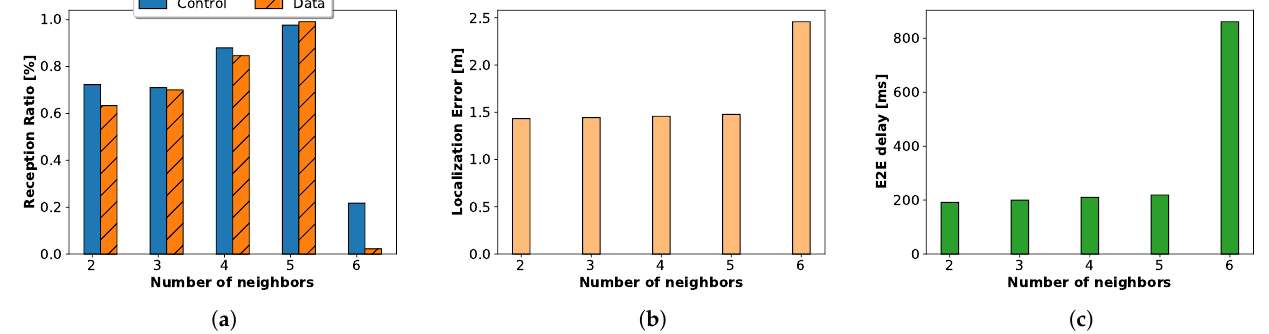
Figure 13. Simulation results for increasing number of neighbors with SDMob—( a ) PDR; ( b ) localiza- tion error; and ( c ) end-to-end delay.